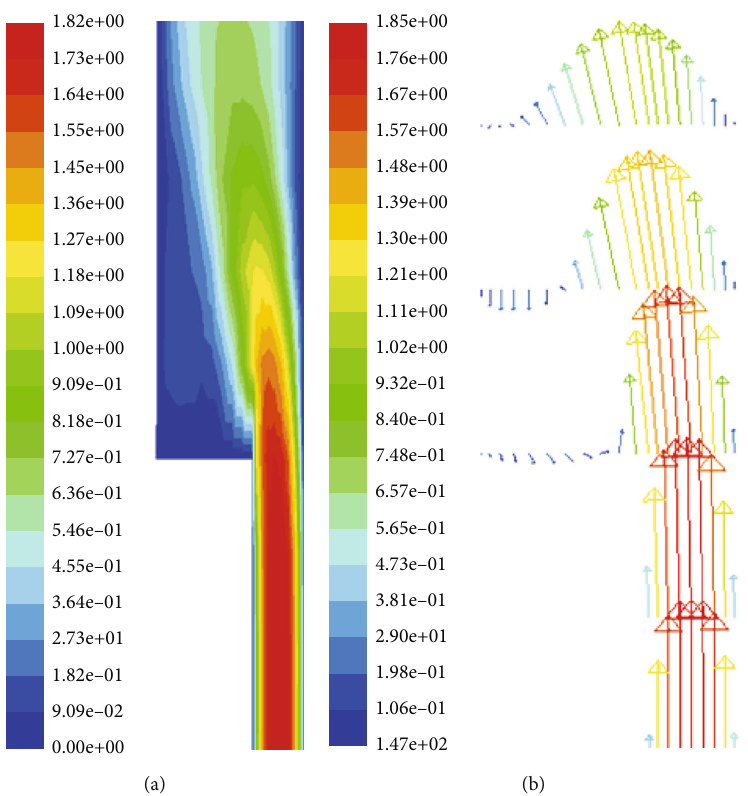
Figure 7: Change of fl ow speed in the junction region of two sections with di ff erent radial sizes: (a) contour of fl ow speed; (b) the corresponding vector diagram.